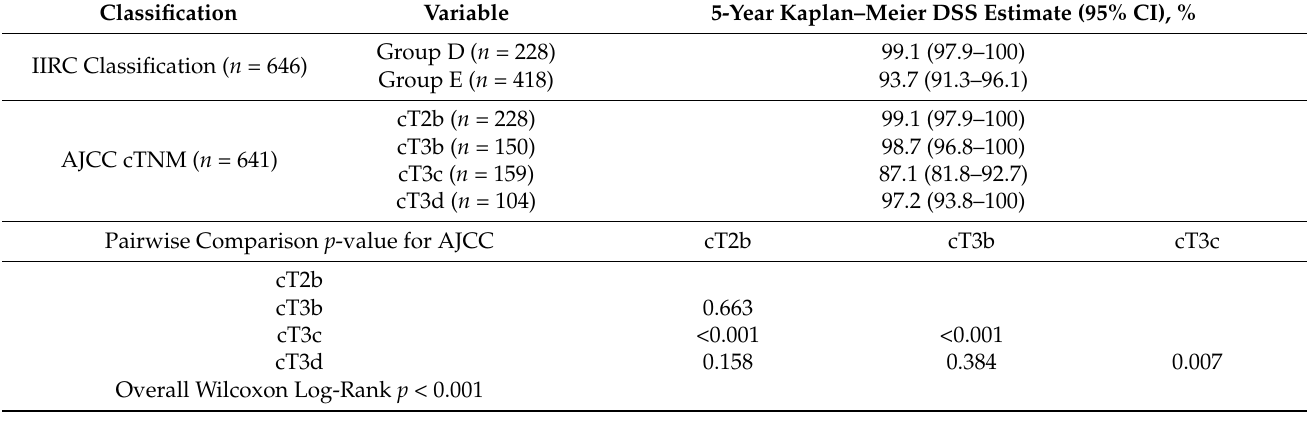
Table 2. Kaplan-Meier Disease-specific Survival Pairwise Comparison for AJCC Clinical Staging.